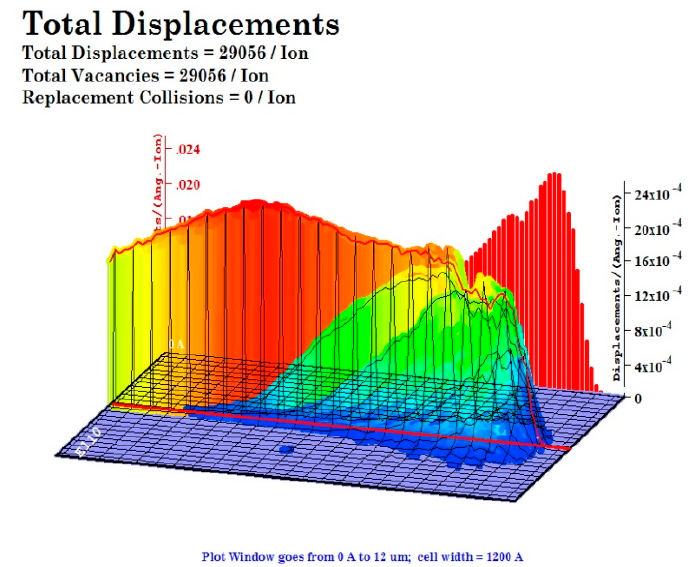
Figure 8. Damage caused by 120 MeV Ru in E110 alloy.